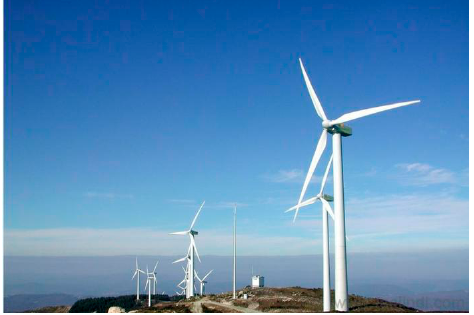
Figure 1. Horizontal-axis wind turbine . Reprinted from Li [23] with permission under the terms of the Creative